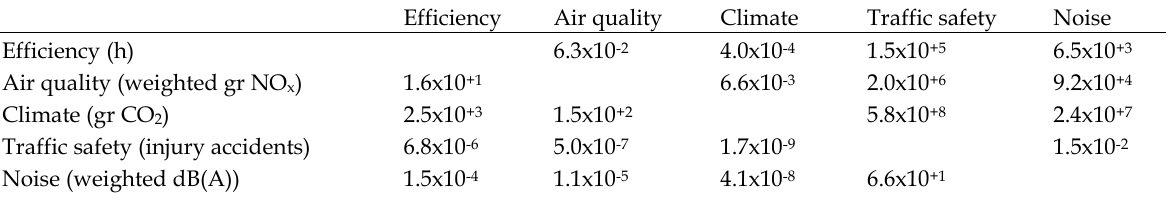
Table 4. Average trade-offs between objectives